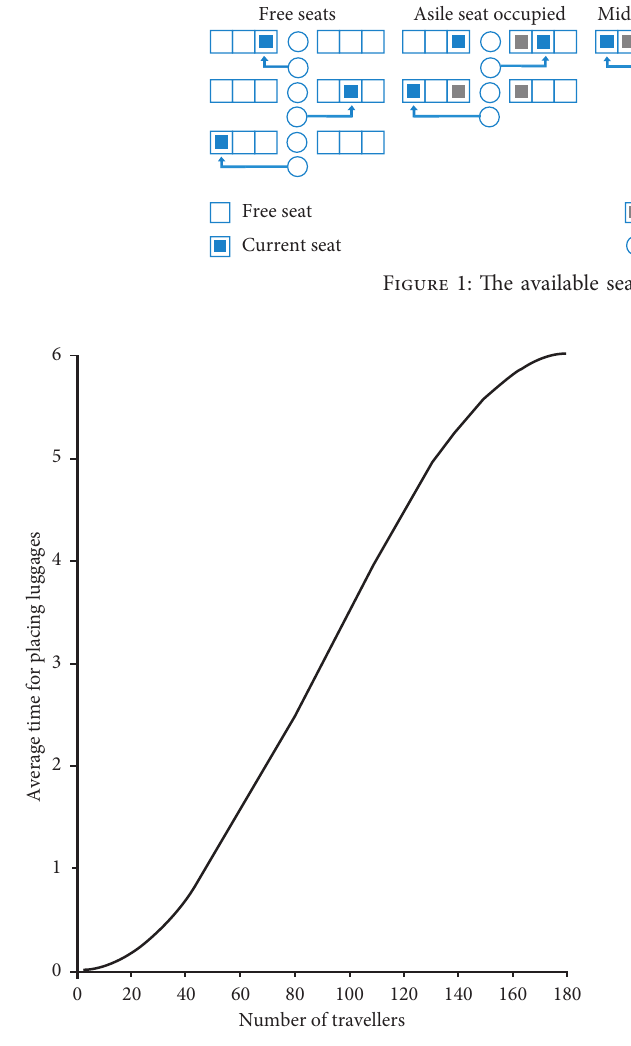
Figure 2: Average time of placing luggage to the number of